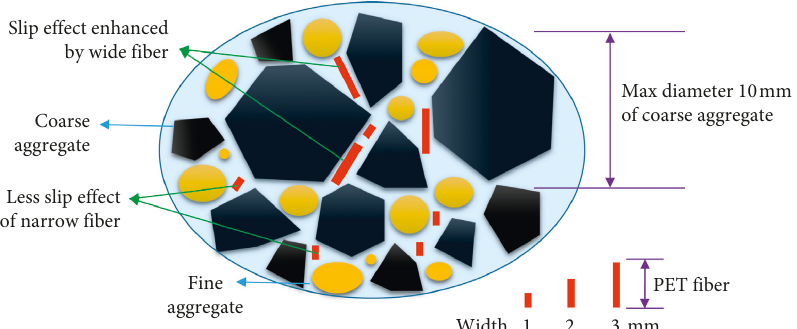
Figure 10: Schematic of the effect of PET fiber width on aggregate bonding.